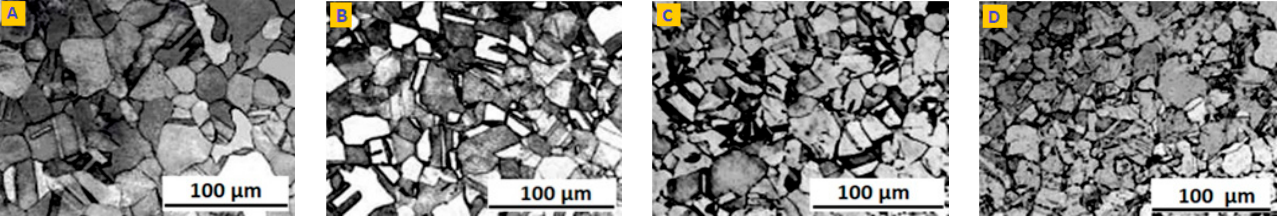
Figure 2. Microstructure ( A ) as-received and ECAP samples of Al5083 alloy after the ( B ) 1st pass, ( C ) 2nd pass, and ( D ) 3rd pass.